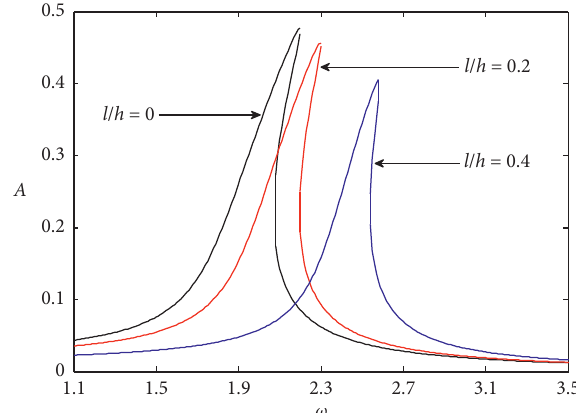
Figure 5: The frequency-response curves of the system for different damping coefficients C .